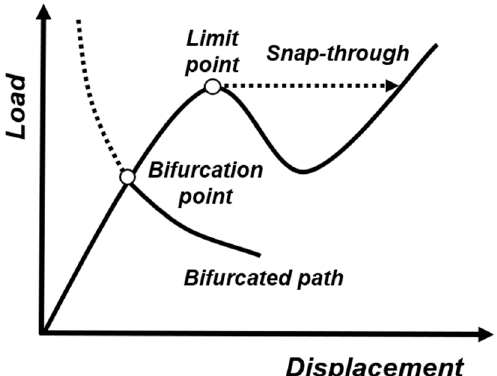
Figure 7. Bifurcation and snap-through point in a representative force-displacement curve.